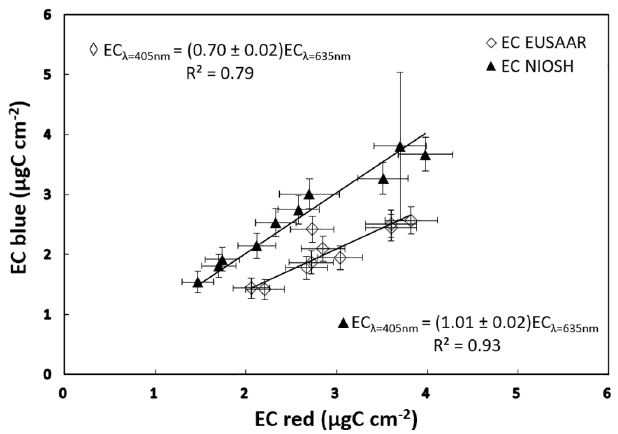
Figure 4. EC concentration measured in two subsets of PM 10 sam- ples collected in consecutive days in the urban area of Genoa in late spring 2016. Values determined with the Sunset analyzer equipped with blue and red laser diodes are